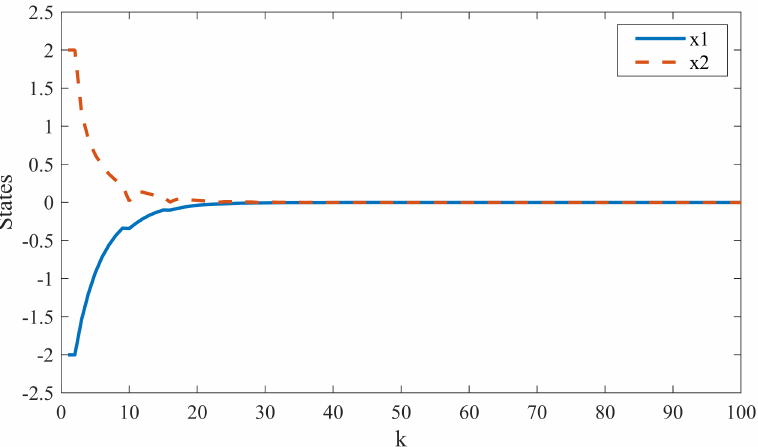
Figure 5. Performance of the co-design of the control and GMRS for the NCS without zero-order hold.